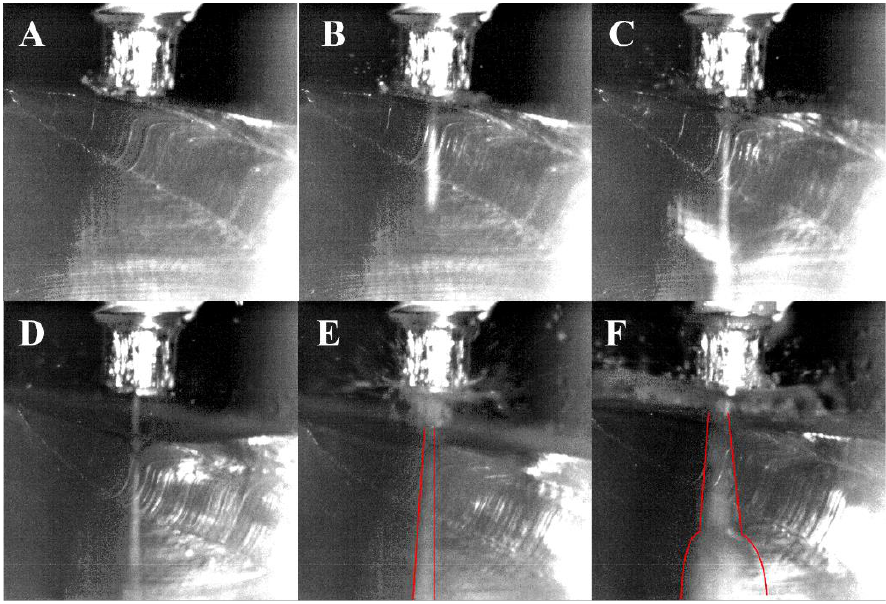
Figure 10. High-speed sequence of servo-tube injector penetrating 10% ballistic gel. ( A – F ) shows the injection snapshots at increasing time sequence.